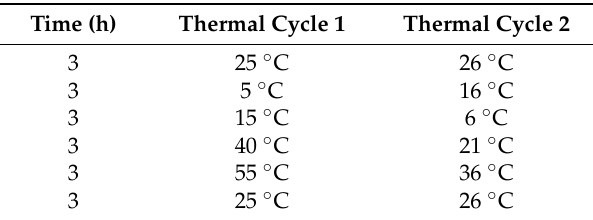
Table 3. Thermal cycles